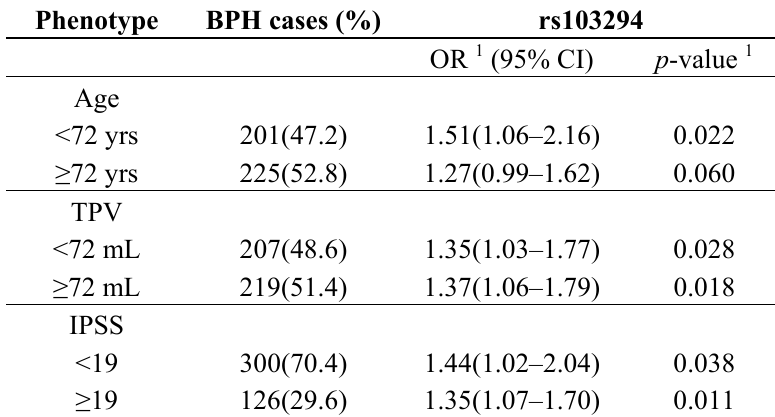
Table 4. Stratified analysis for association with BPH risk based on age, total prostate volume (TPV) and International Prostate Symptom Score